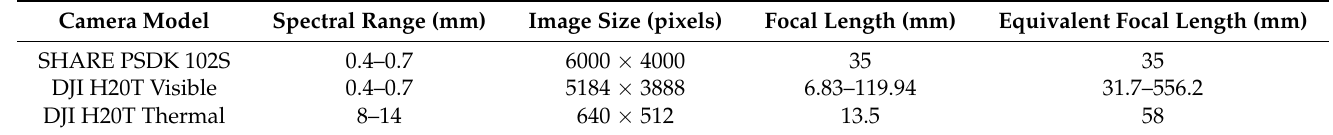
Table 2. Cameras specifications.The specific parameters of the three cameras used in our dataset include resolution, wavelength range, and focal